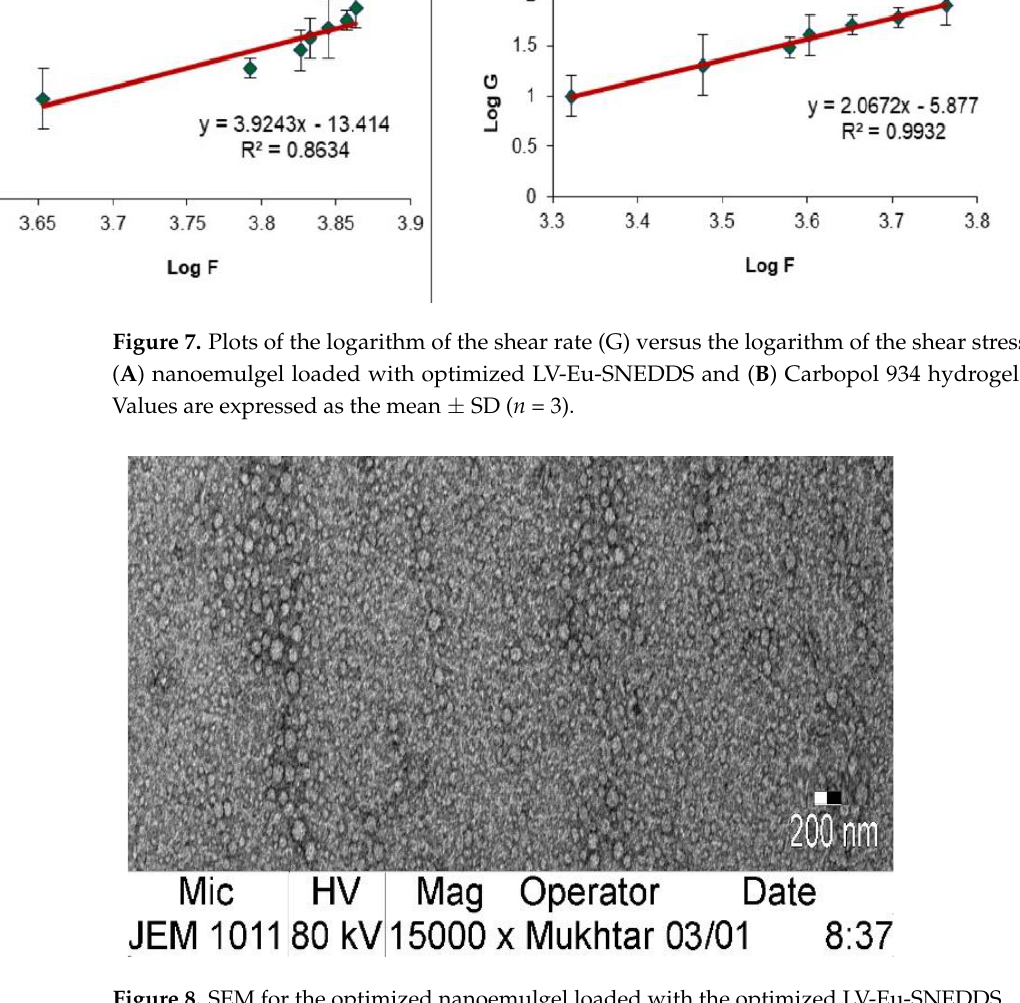
Figure 8. SEM for the optimized nanoemulgel loaded with the optimized LV-Eu-SNEDDS.